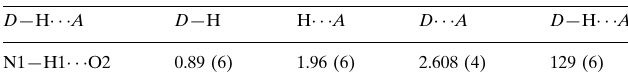
Hydrogen-bond geometry (A˚ , (cid:2)